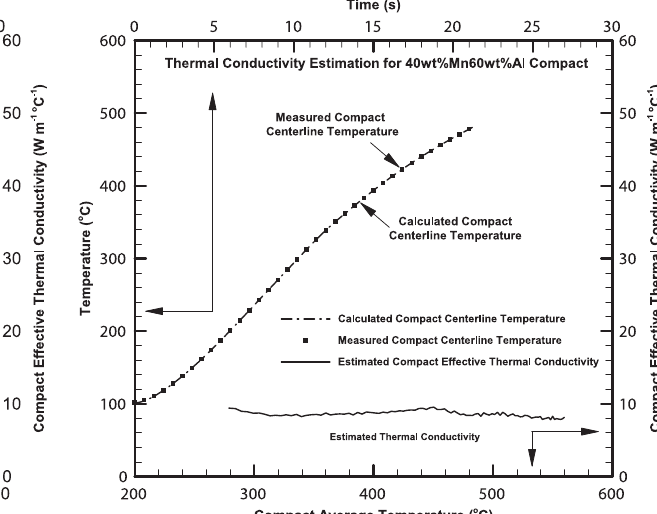
Fig. 15: Estimated Thermal Conductivity of a 40wt%Mn60wt%Al